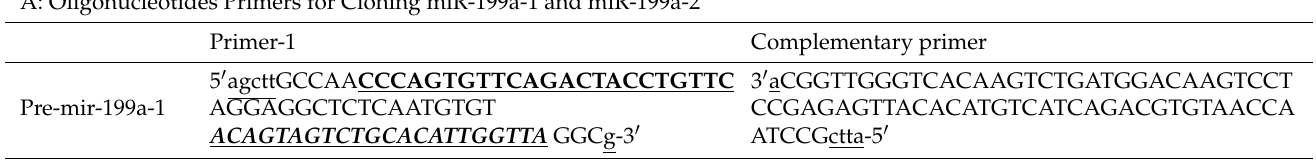
Table 1. Primers used in this